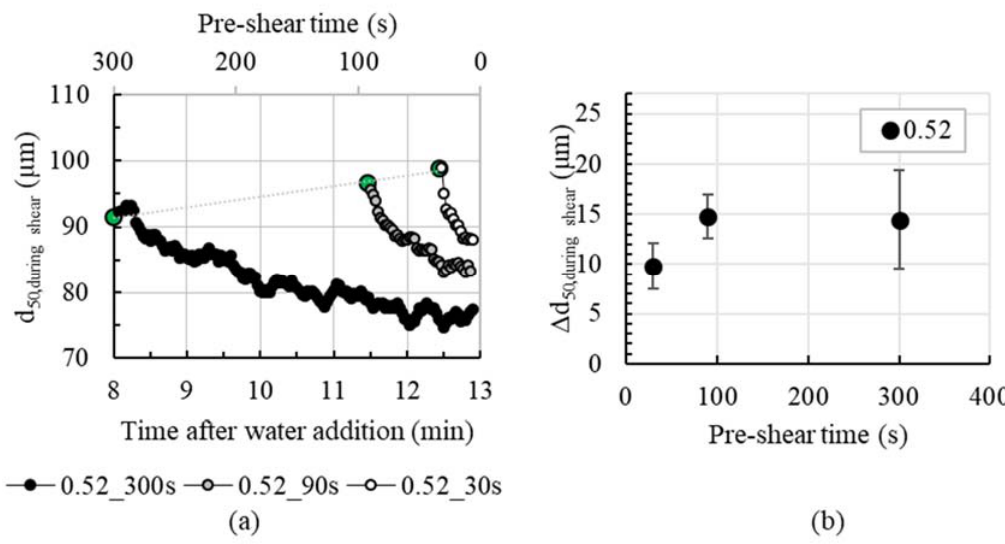
Figure 4. ( a ) Agglomerate size d 50 decreases during shear for pre-shear times of 30 s, 90 s and 300 s (shown here with a moving average with 5 values); ( b ) summarized agglomerate size decrease ∆ d 50 from beginning to end of shear for various pre-shear times (n = 2); both examples are shown for cement paste 0.52.